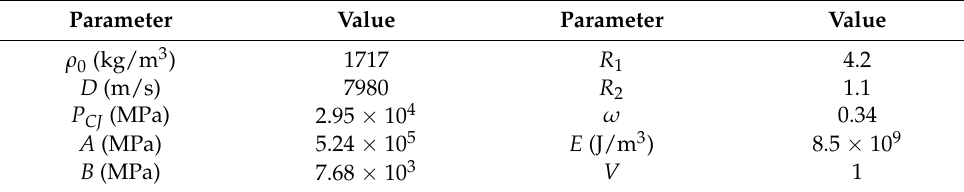
Table 3. B explosive material model and EOS parameters